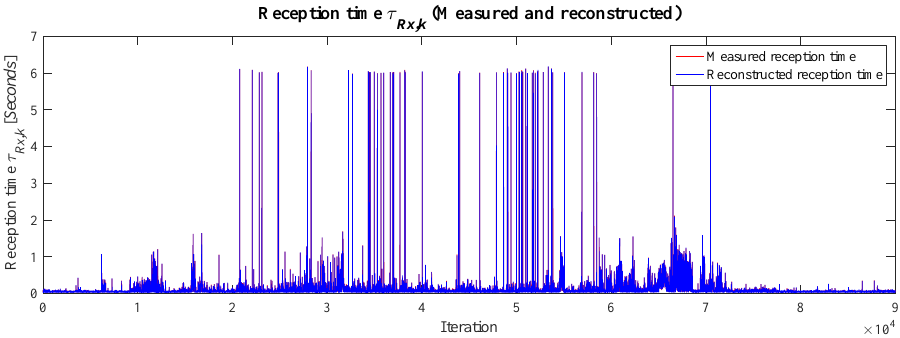
Figure 12. Temporary Kalman gain K T log scale on x -axis).